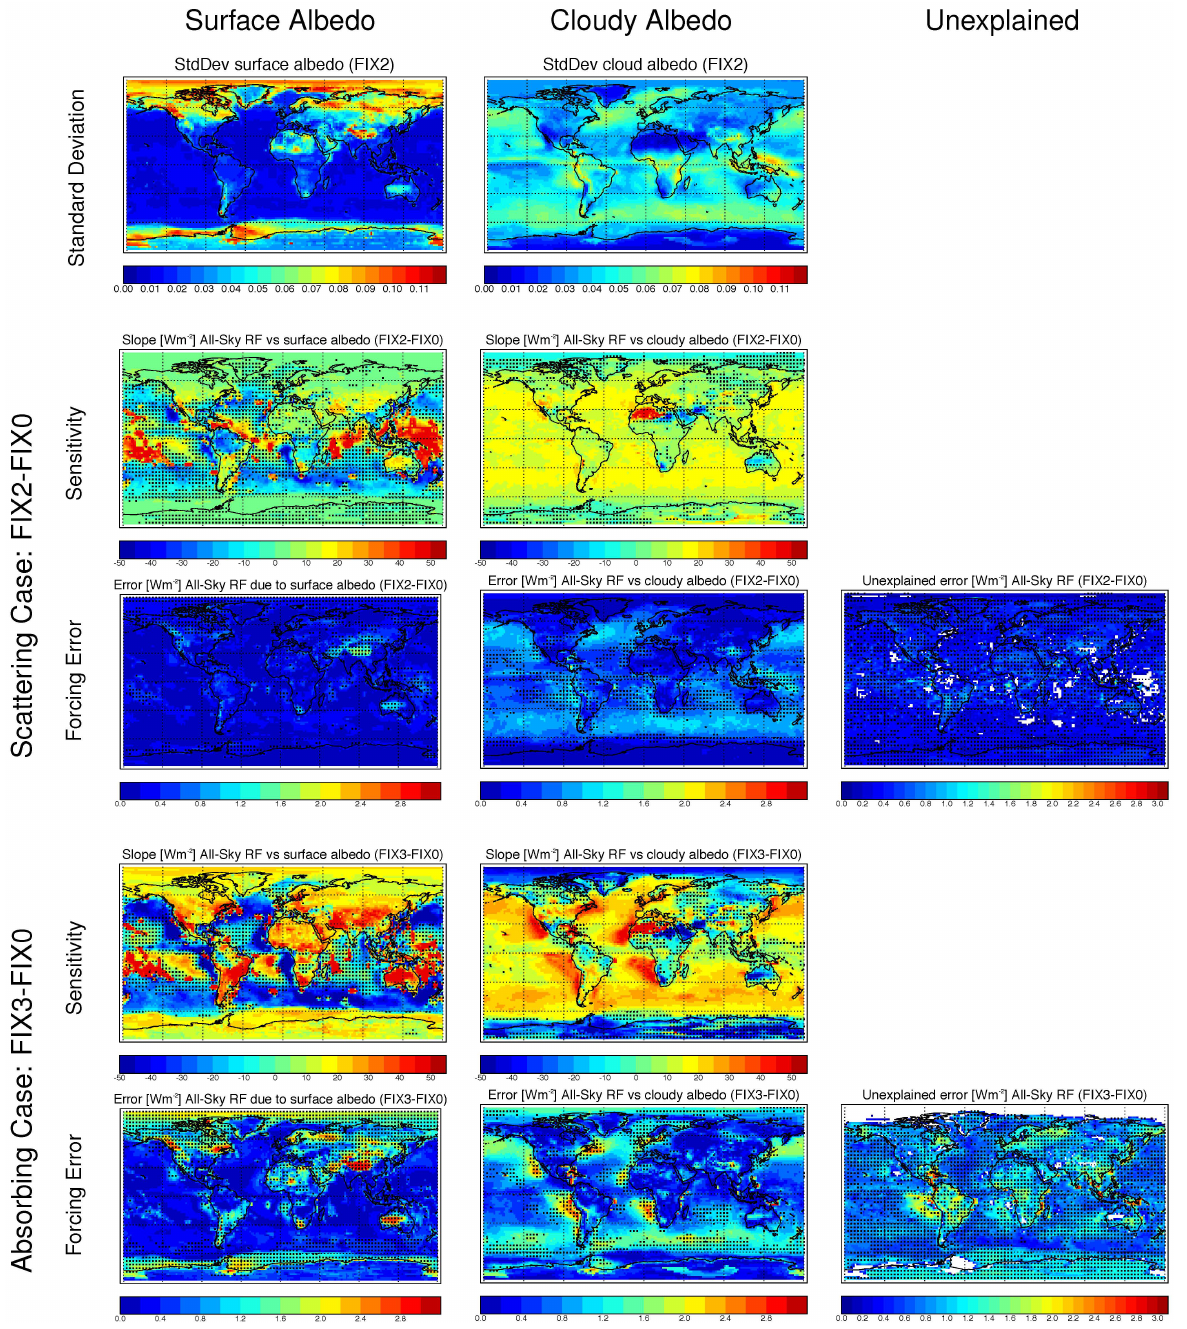
Fig. 19. Decomposition of the impact of host model errors on aerosol radiative forcings. The top row shows the standard deviations in surface and cloud albedo among the models. The sensitivity (linear regression coefficient) of aerosol radiative forcing to either surface or cloud albedo in the models is shown in the second row (for the pure scattering FIX2-FIX0 case) and the fourth row (for the absorbing FIX3-FIX0 case). The forcing error due to either surface or cloud albedo (standard deviation in albedo times sensitivity) is shown in rows 3 and 5. Assuming independent errors, the (remaining) unexplained error in the radiative forcing is shown in the right most column, row 3 and 5. Here the white areas denote regions where the sum of squared errors due to surface or cloud albedo is larger than the deviation in aerosol radiative forcing across the models. The hatching in the sensitivity plots indicates that the sign of the sensitivity may change (due to removing a model). The hatching in the forcing error plots indicates low uncertainty ( < 30%) in the error. Based on annual averaged fluxes for the models CAM-PNNL, GOCART-GEOS, GOCART-MERRA, LMDZ, LMDZ-39L, MPI-2stream, IMPACT, OsloCTM2,